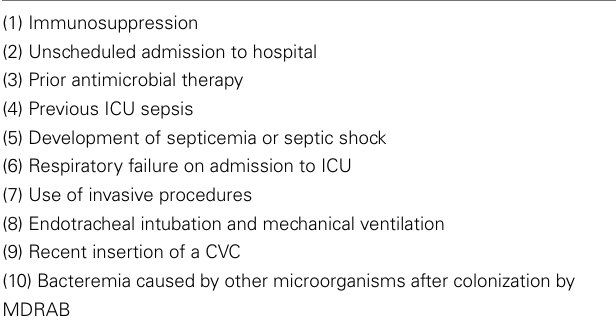
Table 4 | Risk factors for A. baumannii bacteremia